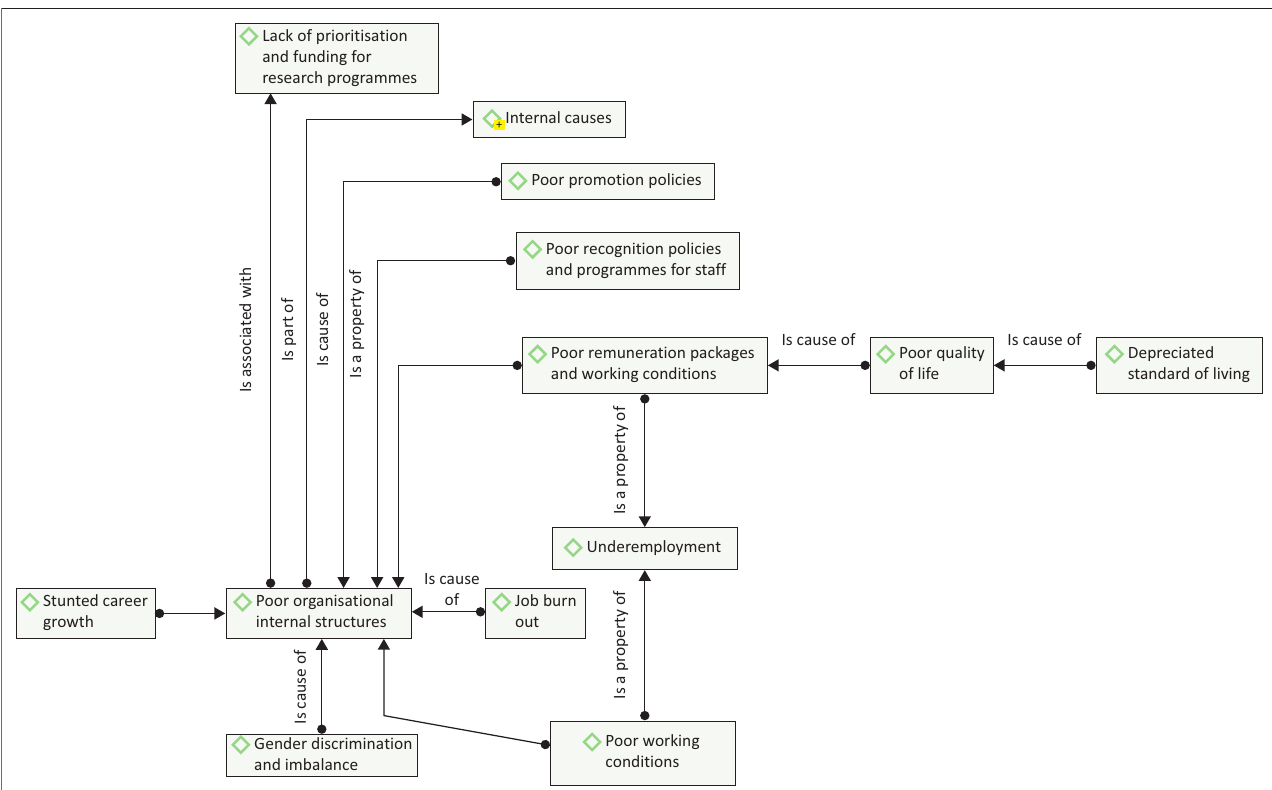
FIGURE 1: Internally induced brain drain